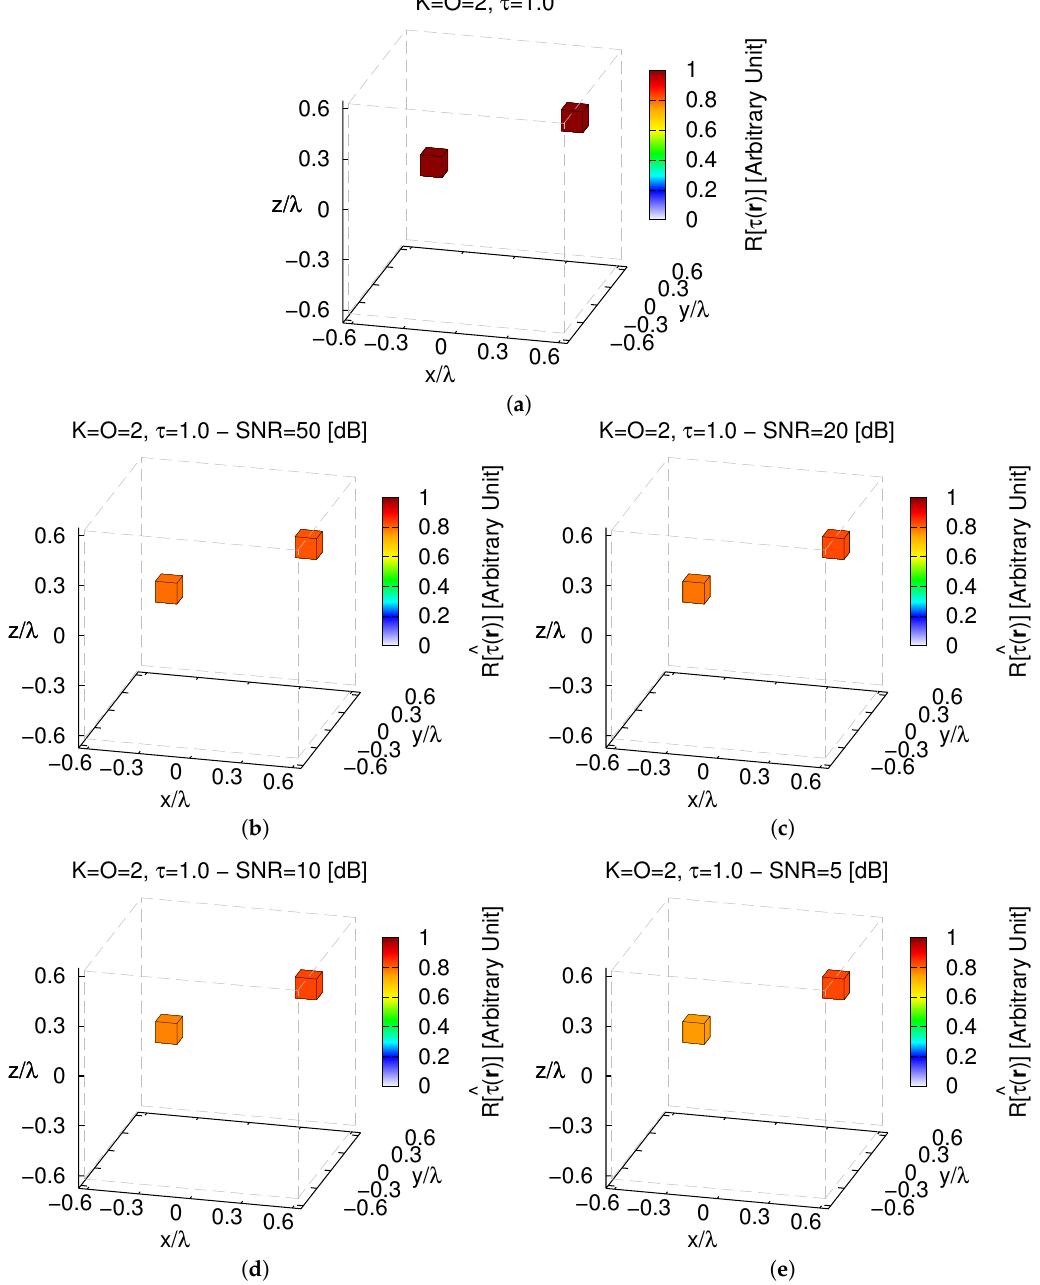
Figure 7. Numerical Assessment ( K = 2, O = 2, τ = 1.0)—( a ) Actual contrast function and MT-BCS reconstructions when processing the scattering data with ( b ) SNR = 50 [dB] ( (cid:98) τ max =